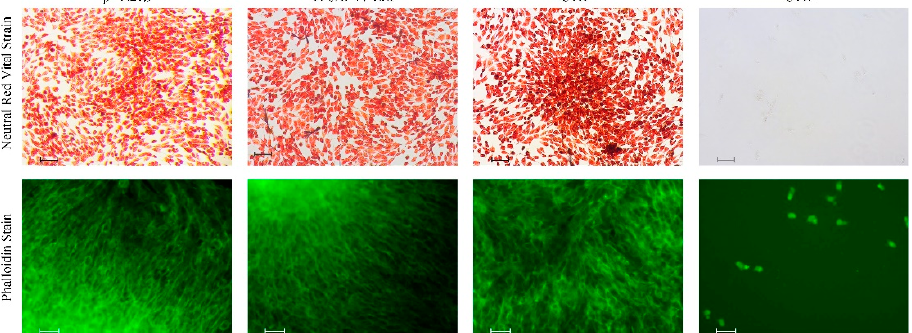
Figure 12. Microscopic images of cells seeded with the β -Ti21S (test), Ti–6Al–4V ELI (reference), and CTR − (cells without material) and CTR+ (cells with a cytotoxic substance) controls. Upper row: cells stained with Neutral Red vital stain (magnification 10×, bar = 100 μ m). Lower row: cells stained with